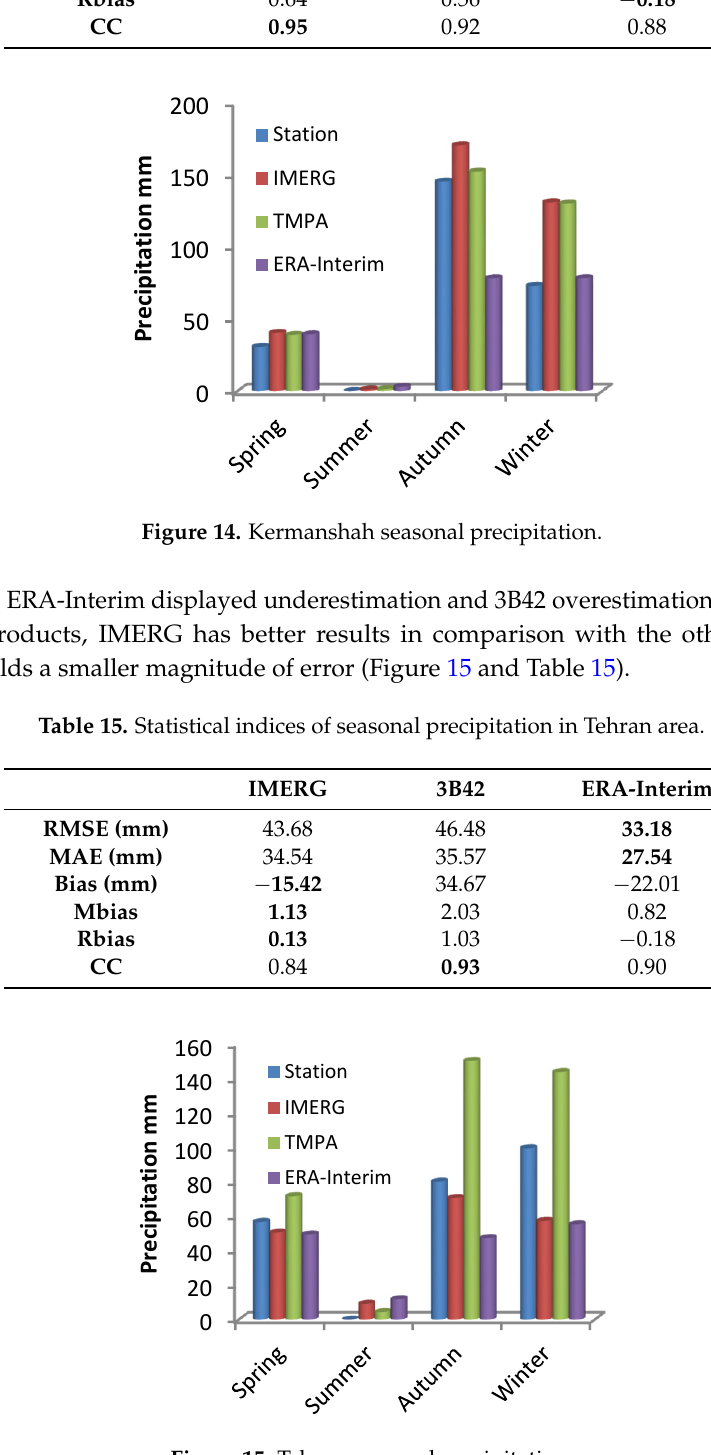
Figure 15. Tehran seasonal precipitation.